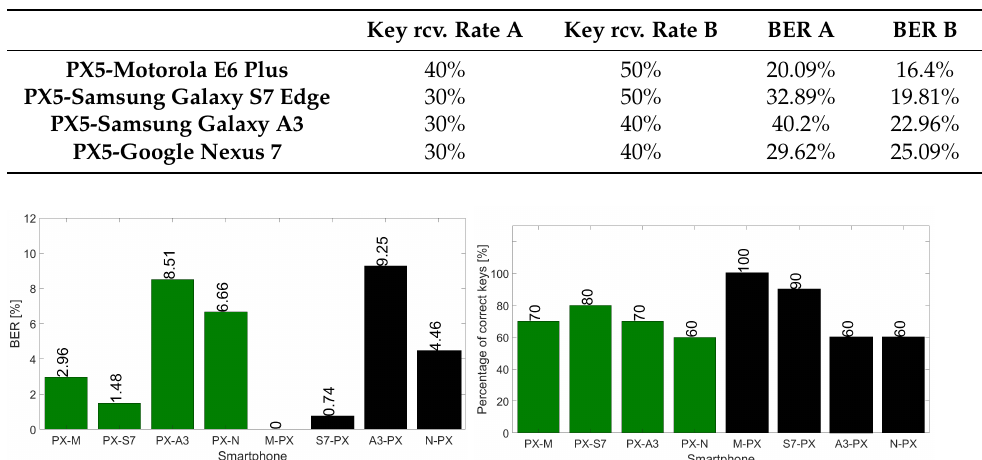
Table 9. Pairing success rate and BER for infotainment experiments with environment noise.